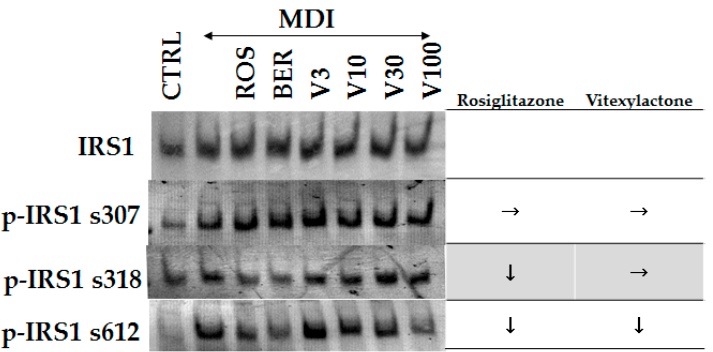
Figure 5. The effects of each compound on the phosphorylation of IRS1 in 3T3-L1 cells during 30 min after the addition of each compound. Protein levels were measured by electroblotting. Undifferentiated cells, cells with the addition of MDI (a mixture of 0.5 mM 3-isobutyl-1-methyl- xanthine (M), 0.1 μ M dexamethasone (D), and 2 μ M insulin (I)), rosiglitazone, berberine, and vitexilactone are indicated by CTRL, MDI, ROS, BER, and V, respectively. → and ↓ represent no change or down-regulation, respectively.